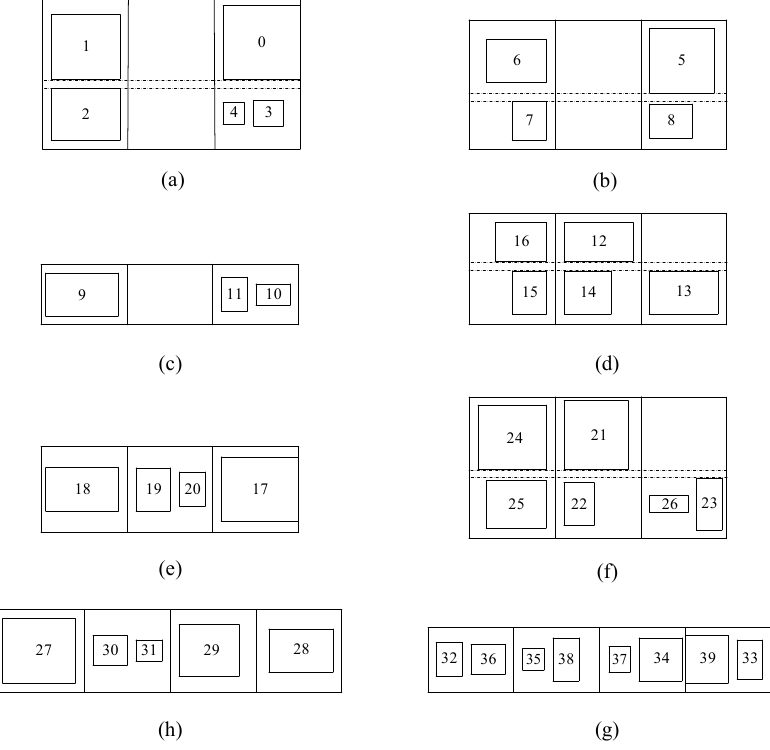
Figure 12. Schematic diagram of the equipment layout in the integrated layout cell. ( a ) — Multi- layer Linear Manufacturing Cell; ( b ) — Multi-layer Linear Manufacturing Cell; ( c ) — Single-layer Manufacturing Cell; ( d ) — Multi-layer U-shaped manufacturing cell; ( e ) — Single-layer U-shaped manufacturing cell; ( f ) — Multi-layer U-shaped manufacturing cell; ( g ) — Single-layer Ring Manu- facturing Cell; ( h ) — Single-layer Ring Manufacturing Cell.